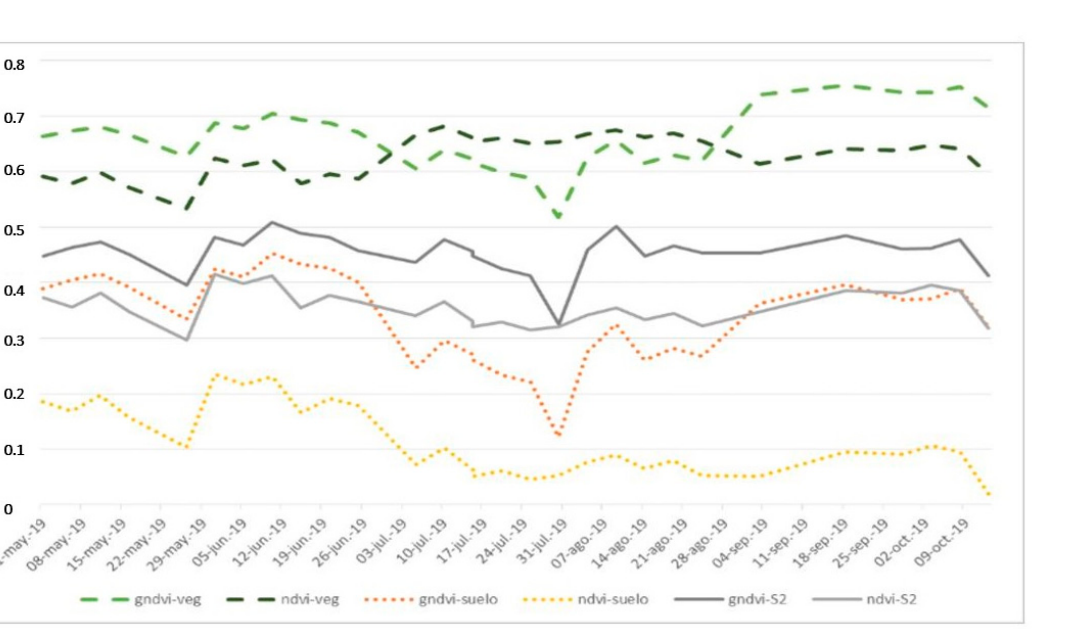
Figure 5 . Evolution of the GCI spectral indices of a point associated with vegetation (green striped line: gci-veg), of a point associated with soil (brown dotted line: gci-soil) and of the pixel in which these points are located in the Sentinel 2 images (gray continuous line: gci-S2). Period: 1 May to 31 October 2019.